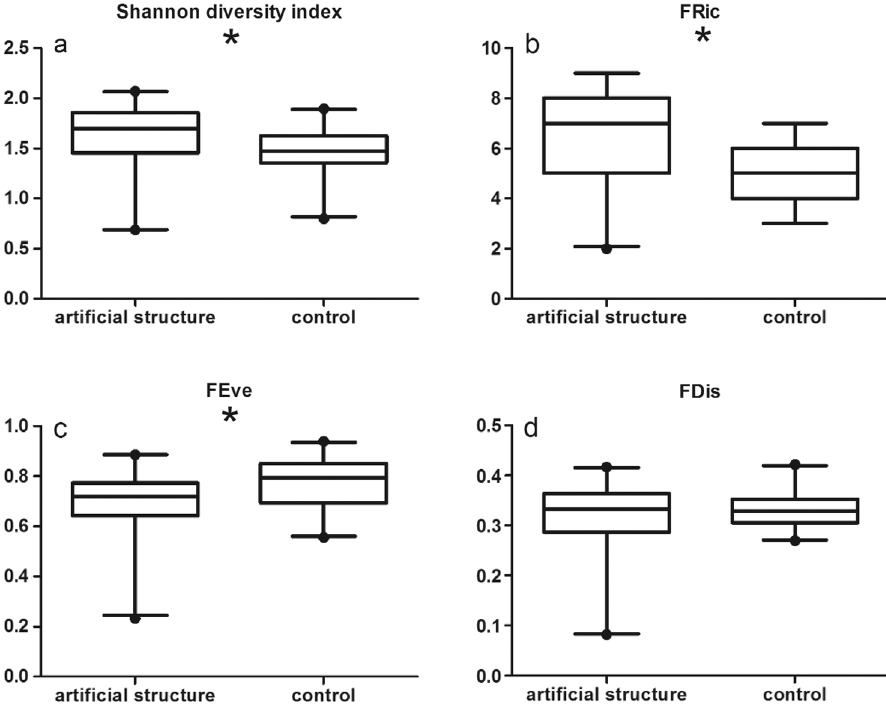
Fig. 5. Box plot of fi sh diversity indices at arti fi cial structures and control sites. (a) Shannon diversity index; (b) functional richness (FRic); (c) functional evenness (FEve); (d) functional dispersion (FDis). * indicated signi fi cant between arti fi cial structures and control sites at the 0.05 level. Whiskers: 5 – 95